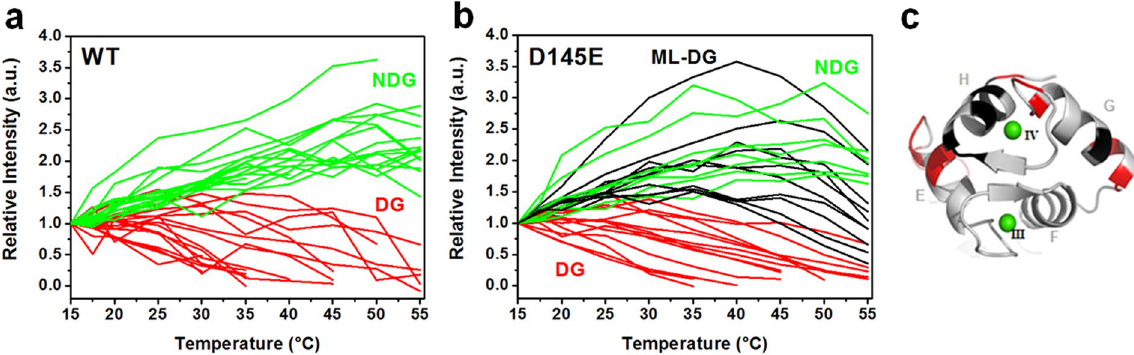
Figure 5. C-domain residues of WT and D145E isoforms differ in stability, as measured by NMR cross- peak intensities between 15° and 55 °C. ( a , b ) Changes in resonance intensities of the C-domain as a function of temperature, normalized to values at 15 °C. Green residue intensities are unperturbed or increased by temperature changes and classified as non-decaying group (NDG). Red residues lose intensity and are classified as decaying group (DG). In Black is the biphasic decaying group (“mountain-like”, ML-DG) for D145E. ( c ) Bottom view of the mutant cTnC C-domain, highlighting in black and red the residues identified respectively as ML-DG and DG in panel (b). Calcium ions are shown as green spheres. Truncated curves in ( a ) and ( b ) represent peaks that were lost due to line broadening or overlap at higher